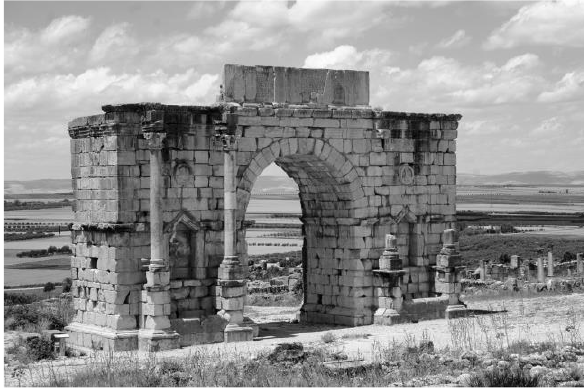
Figure 5. Arch of Caracalla (photo by G. Pancani,